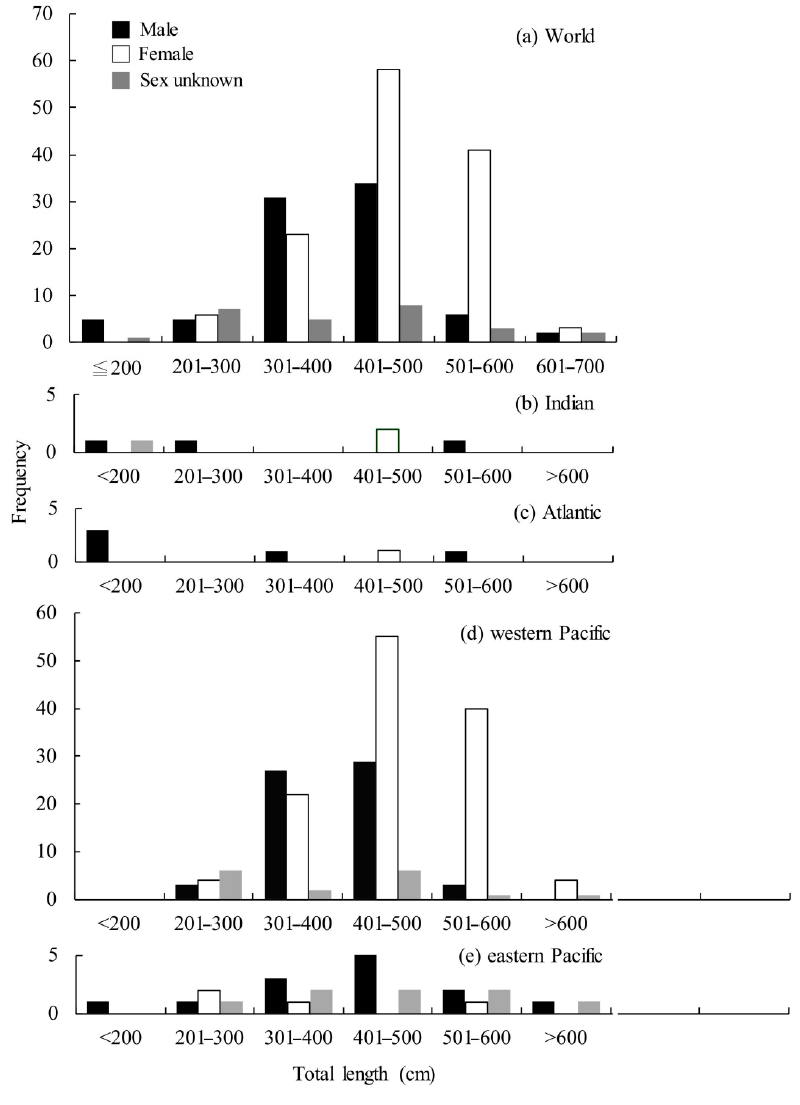
Figure 3. ( a ) Total length frequency of M. pelagios in the ( a ) three oceans, ( b ) Indian Ocean, ( c ) Atlantic Ocean, ( d ) Western Pacific Ocean, and ( e ) Eastern Pacific